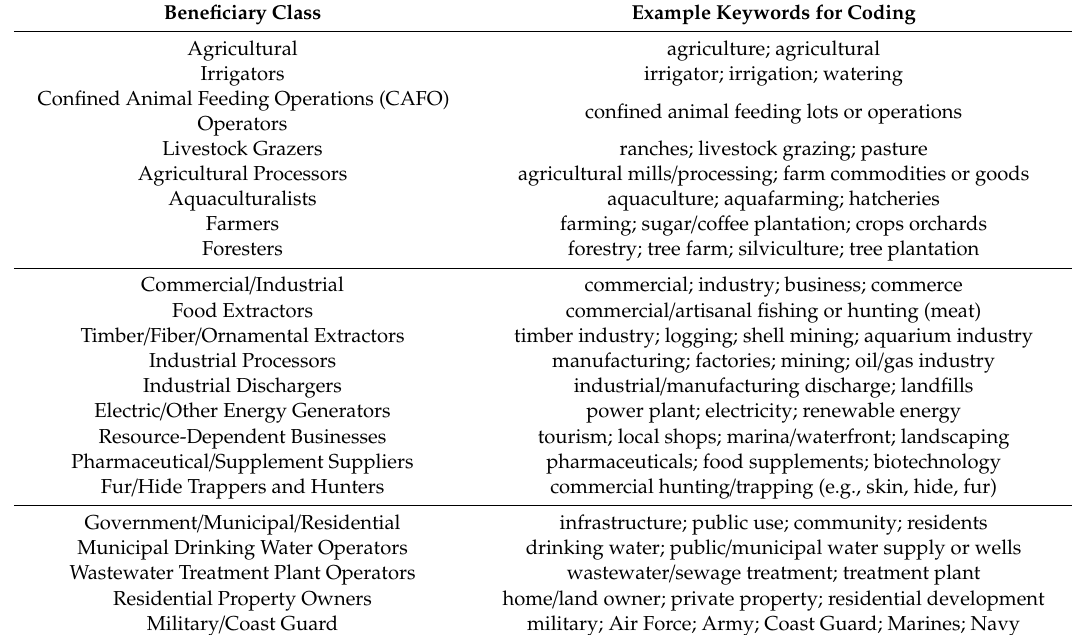
Table 3. Example keywords used to code each category of beneficiary (full list in Supplementary Table